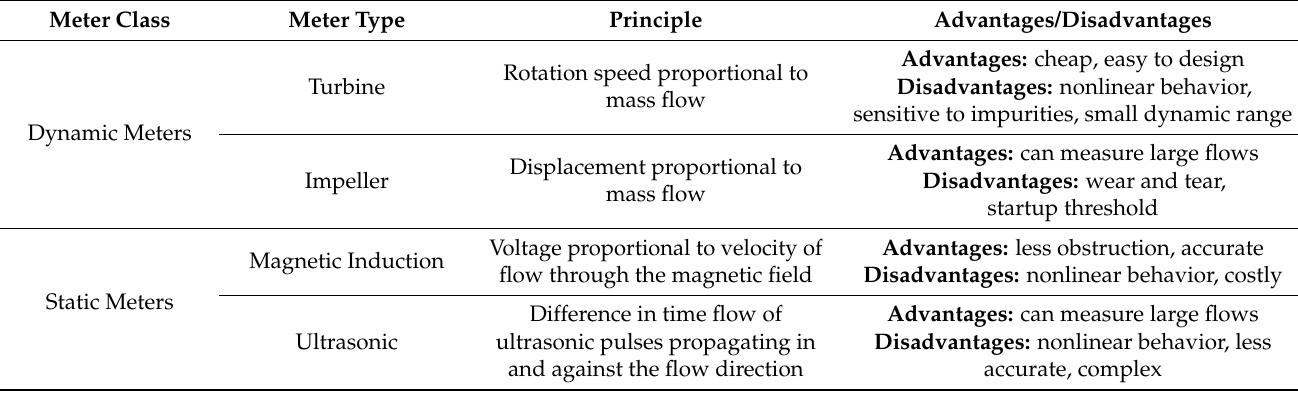
Table 2. Review of different types of heat